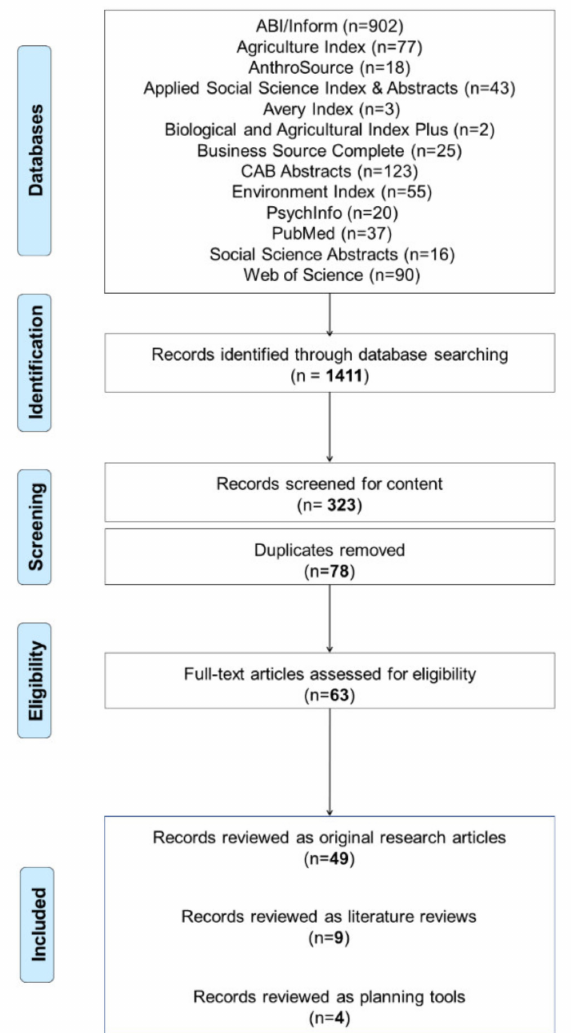
Figure 1. Flow chart describing the literature databases searched and the article screening, eligibility, and inclusion